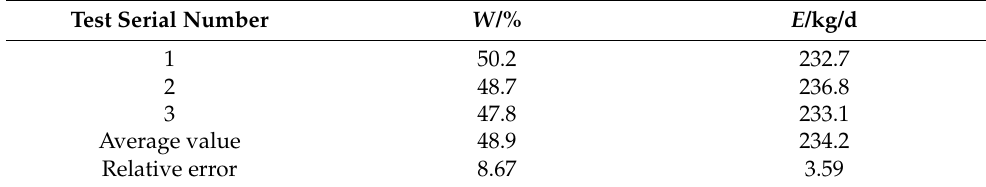
Table 4. Test results of each target under parameter